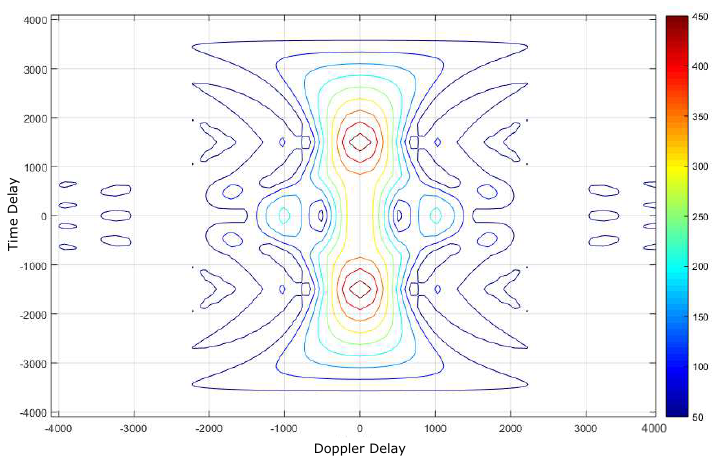
Figure 11. Two nearby scatterers using square pulses: 2D, with no noise.